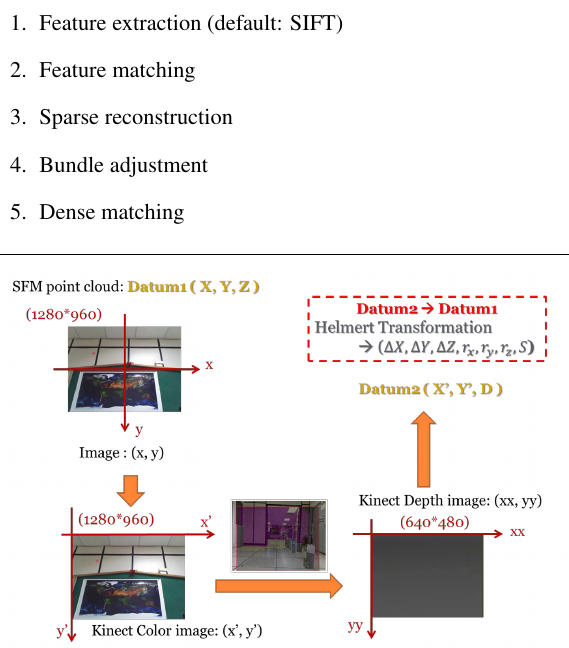
Figure 2: Determining Helmert 7-parameters from feature